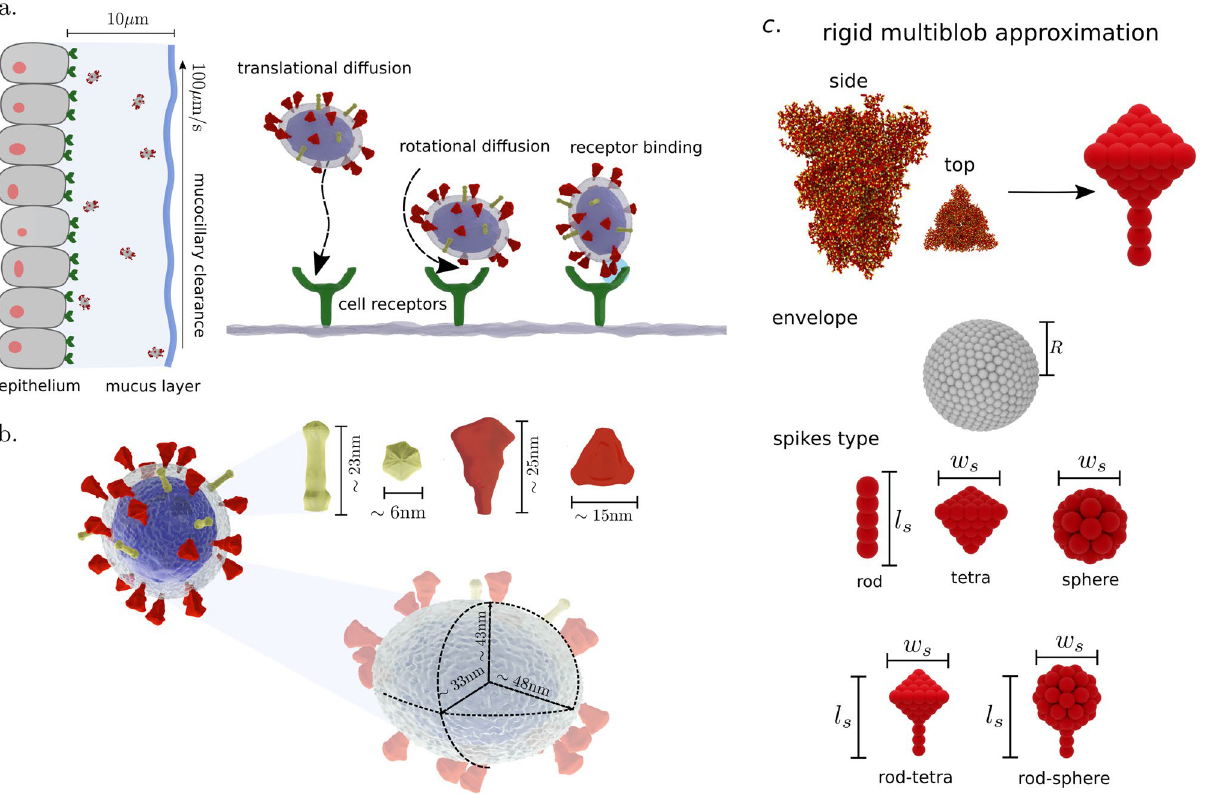
Figure 1. Sketch of viral transport and discretization. ( a ) Representation of viral transport within the first barrier of the respiratory system. Virions diffuse while are advected by the mucociliary clearance mechanism (speed ∼ 100 µ m/s ). Effective binding requires translational and rotational diffusion of the virion to the receptor. ( b ) Schematic of SARS-CoV-2 characteristic envelope and spikes size. Tetrahedral-shape prefusion S in red and needle-shape postfusion S in yellow. Our envelope and spike discretization for viron diffusion based on the size of the spikes reported experimentally 11 . ( c ) Hydrodynamic interactions on the scale of the S size sphere. Rod, tetra, and sphere are characterized by a single length, whereas rod-tetra and rod-sphere require two